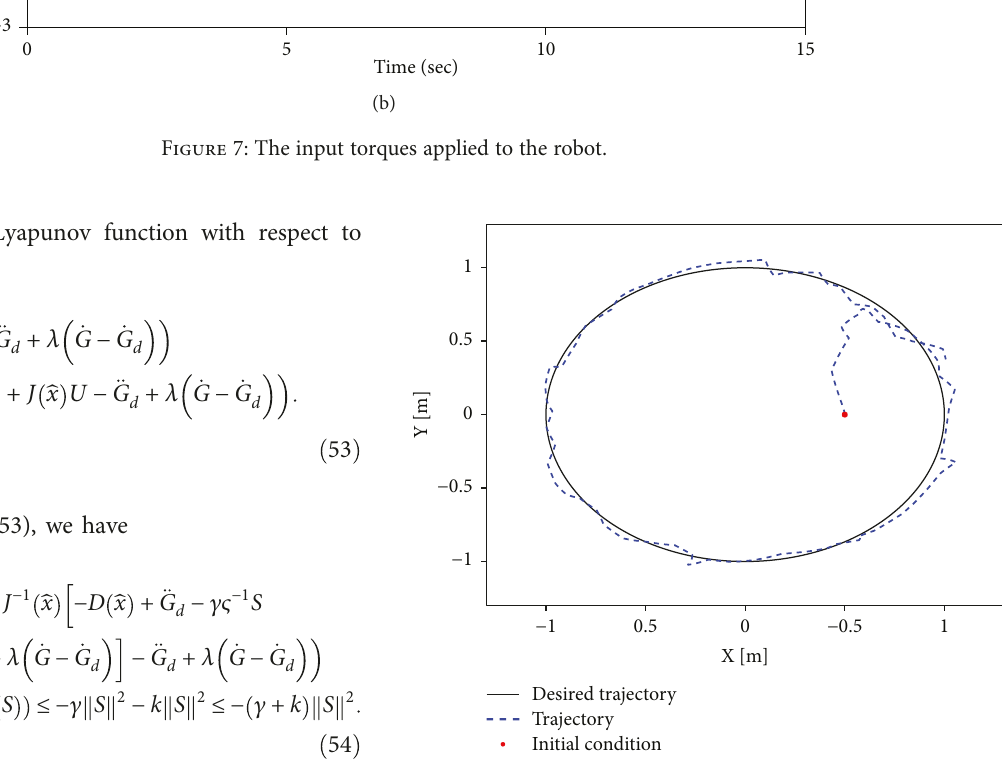
Figure 8: Robot trajectory in the X – Y plane.